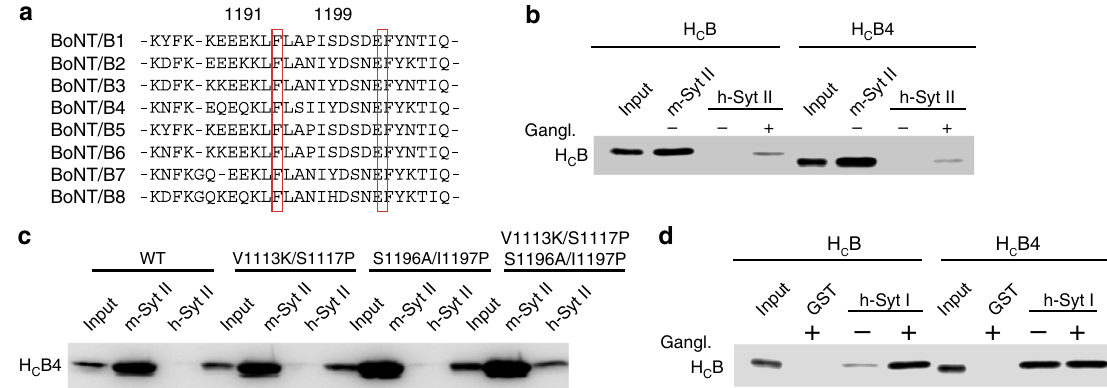
Fig. 5 Variations in BoNT/B subtypes in fl uence their binding to h-Syt II and h-Syt I. a Sequence alignment of BoNT/B subtypes in the region around residues E1191/S1199. b H C B4 showed robust binding to m-Syt II, but no detectable binding to h-Syt II without gangliosides, which is similar to H C B. Both showed low levels of binding to h-Syt II in the presence of gangliosides. c There are four residues that differ between H C B4 and H C B within the 19 key residues in the Syt-binding pocket besides E1191Q/S1199Y. Replacing all four residues in H C B4 with the corresponding residues in H C B created a mutant H C B4 (V1113K/S1117P/S1196A/I1197P) that can bind to h-Syt II. The sequence alignment between H C B and H C B4 is shown in Supplementary Fig.